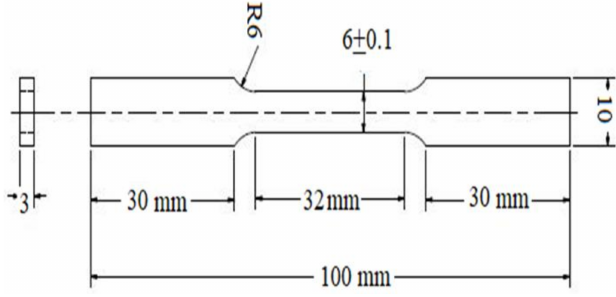
Figure 1. Schematic diagram of steel sample with